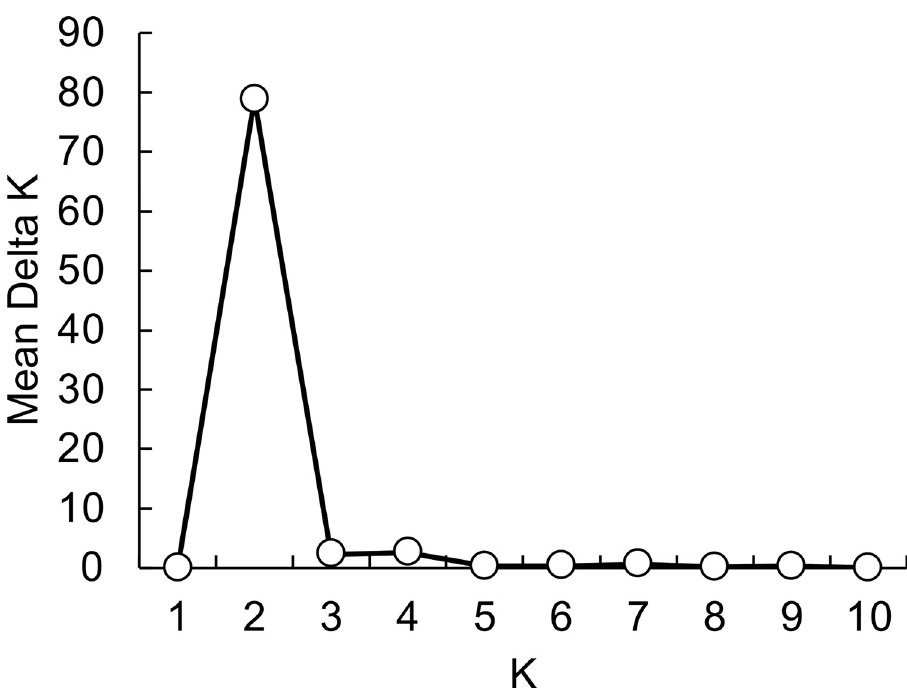
Fig 4. Determination of optimal K by structure harvester. K = 2 was considered as the optimal number of populations.